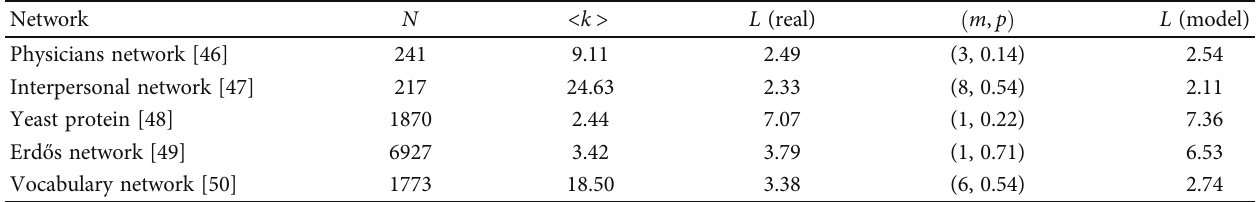
Figure 7: Average shortest path length ( L ) from simulation ( N = 1000 ). Table 1: Comparison of average path length between real and simulation